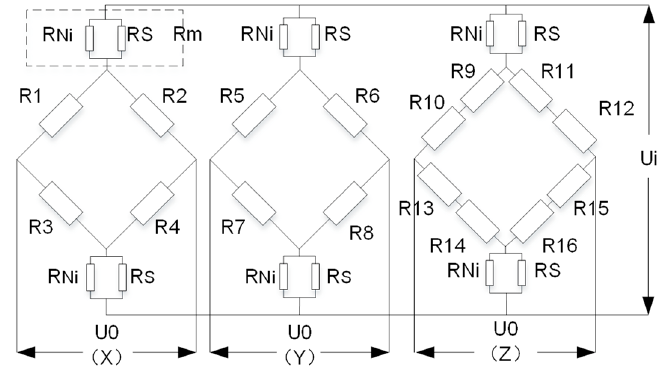
Figure 4. Strain gauge bridge and compensation circuit.